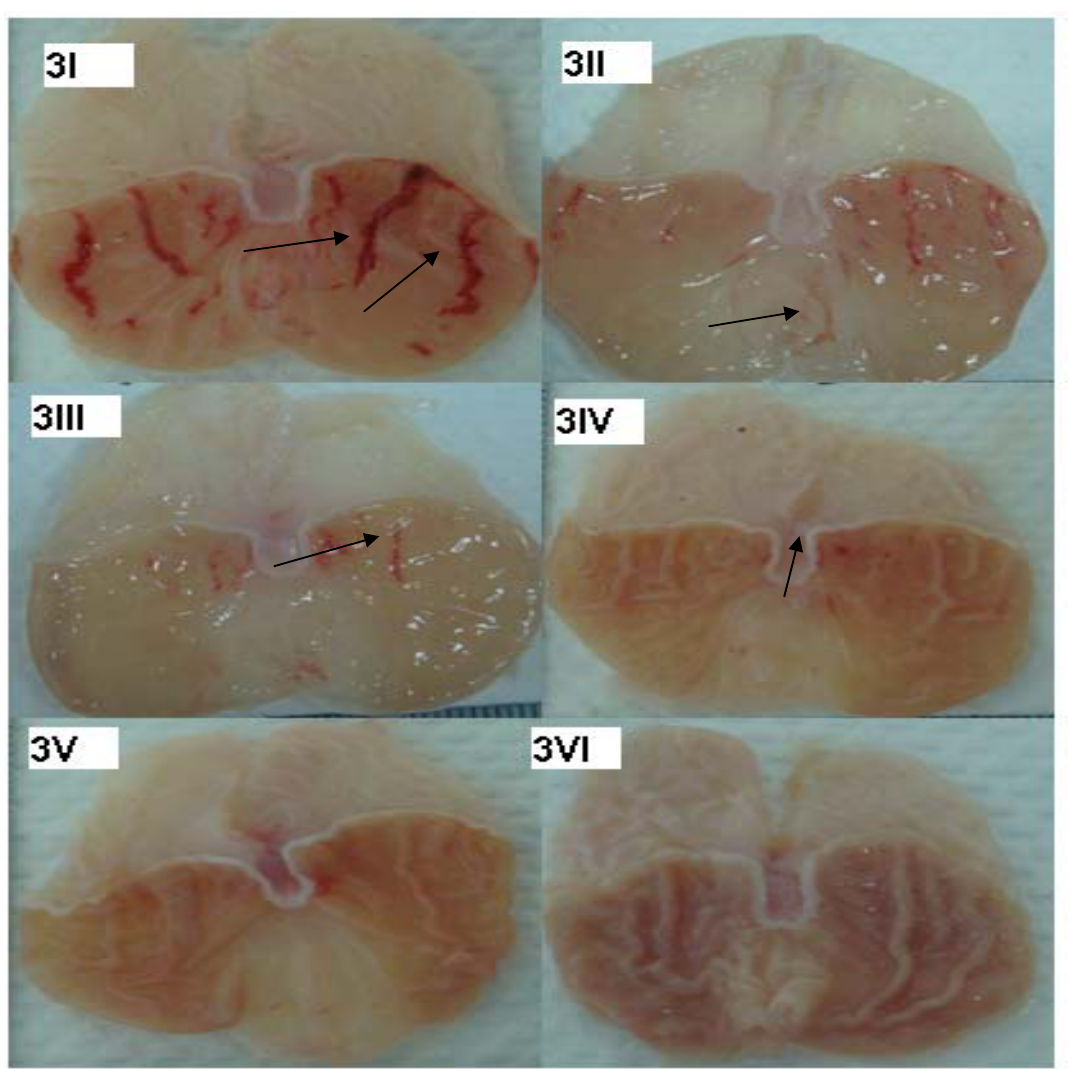
Figure 3. Gross appearance of the gastric injuries in rats. ( 3I ) Rats pre-treated with 5 mL/Kg distilled water (ulcer control). Severe injuries are seen in the gastric mucosa (arrow). Absolute ethanol produced extensive visible hemorrhagic necrosis of gastric mucosa; ( 3II ) Rats pre-treated with omeprazole (20 mg/Kg). Injuries to the gastric mucosa are very milder (arrow) compared to the injuries seen in the ulcer control rats; ( 3III ) Rat pre-treated with CuLBS (30 mg/Kg) and then followed with ethanol (CuLBS-Et, 30 mg/Kg). Mild to moderate injuries are seen in the gastric mucosa (arrow). The compound reduces the formation of gastric lesions induced by absolute ethanol; ( 3IV ) Rats pre-treated with CuLBS (60 mg/Kg) and then followed with ethanol (CuLBS-Et, 60 mg/Kg) Very mild injuries are seen in the gastric mucosa (arrow); ( 3V ) Rats pre-treated with CuLBS alone (60 mg/Kg), no injuries to the gastric mucosa are seen ( 3VI ). The normal rats, no injuries to the gastric mucosa are